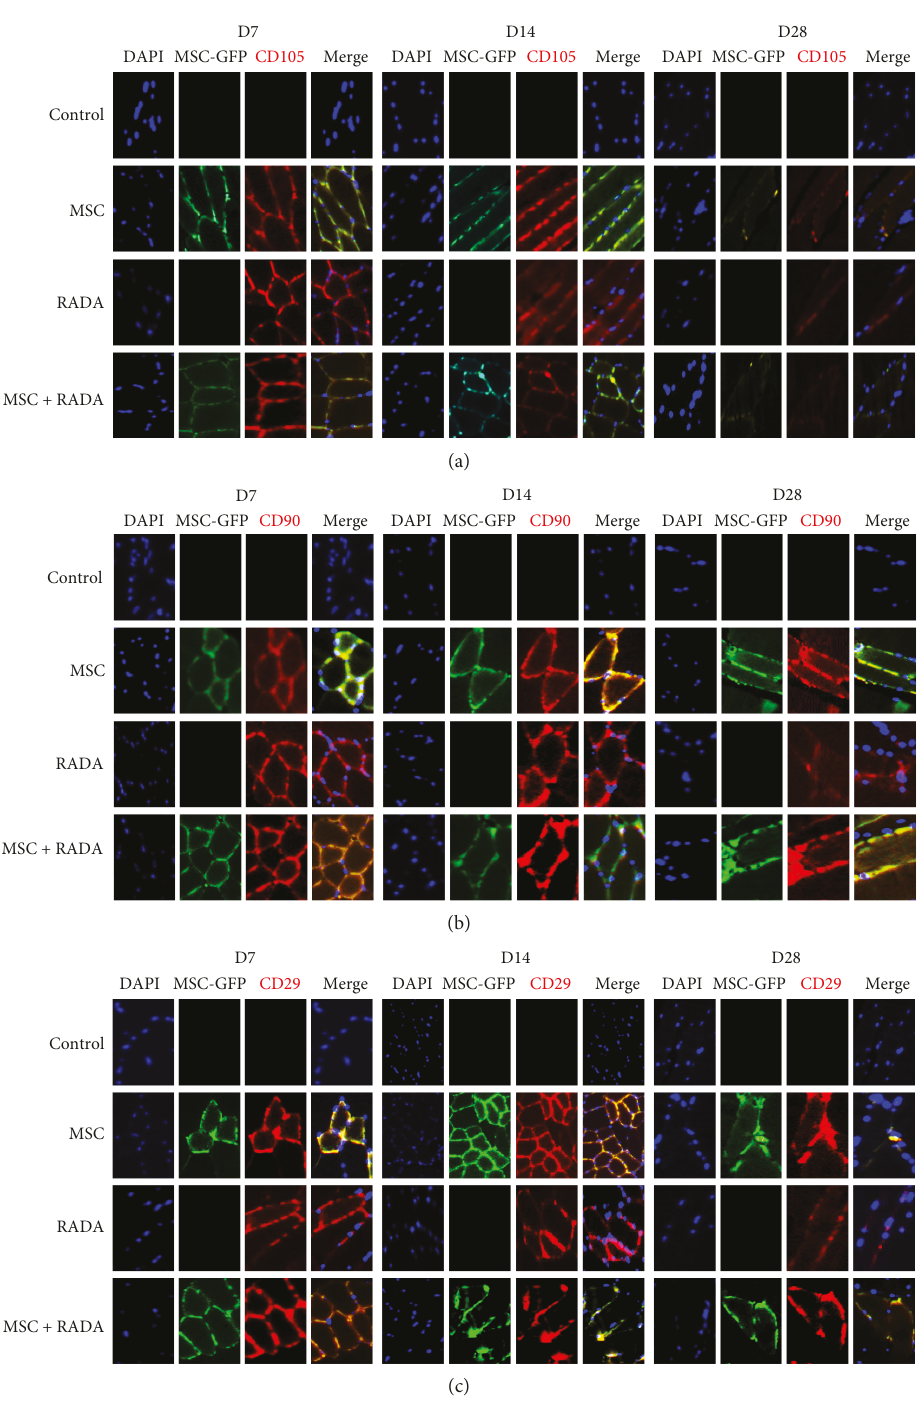
Figure 2: Fluorescent immunohistochemical staining of stem cell markers (a) CD105, (b) CD90, and (c) CD29 for MSCs, RADA, MSCs +RADA, and control (10x magni fi cation). Injected MSCs previously tagged with GFP stained green in the presence of MSCs (second column for each time point). The di ff erent stem cell markers were stained for (third column for each time point) and showed the presence of stem cells, not only in the MSC and MSC +RADA group, but also in the RADA-alone group, suggesting the presence of stem cells probably from the recruitment of endogenous MSCs by RADA. The merged images showed a characteristic yellow color from double staining of GFP and stem cell markers (second and fourth row for the di ff erent stem cell markers at di ff erent time points), yet there was no presence of endogenously recruited MSCs in the combination group which would have shown a red stain only in the merged images (fourth